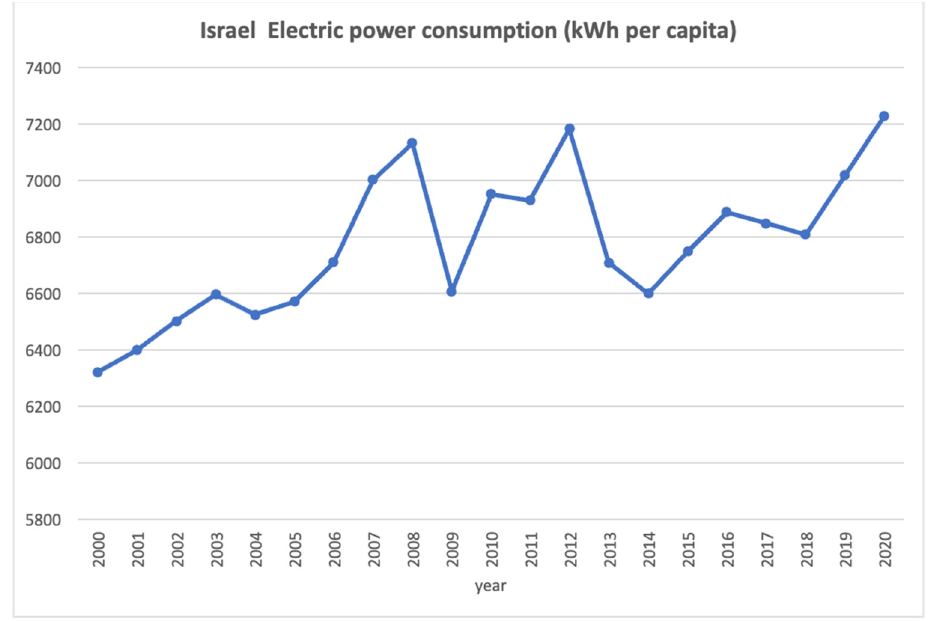
Figure 1. Israel’s electric power consumption per capita (2000–2020). Data source: IEA Energy Atlas International Energy Agency.